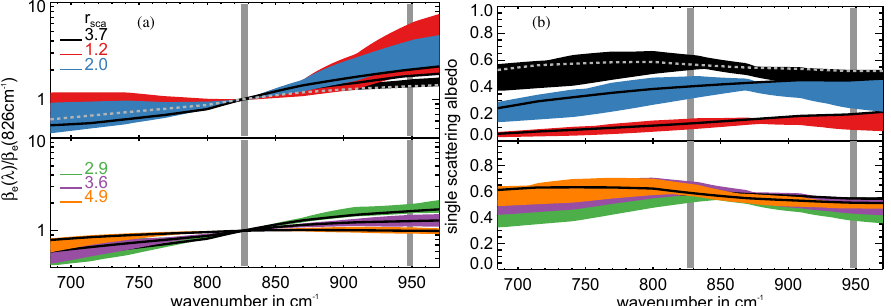
Fig. 2. (a) Extinction coefficient and (b) single scattering albedo spectra for volcanic ash particle size distributions with scattering radii ranging from 1.2 to 4.9 µ m. The corresponding median radii and effective radii are given in Table 2. The extinction coefficient spectra are normalised at 826cm − 1 . The coloured areas denote the variation range due to different refractive index data sets for each size distribution. The black lines denote the Volz (1973) refractive index. The black area and the grey dashed line are calculated for the volcanic ash measurements reported by Schumann et al. (2011) with r sca =3 . 7 µ m.